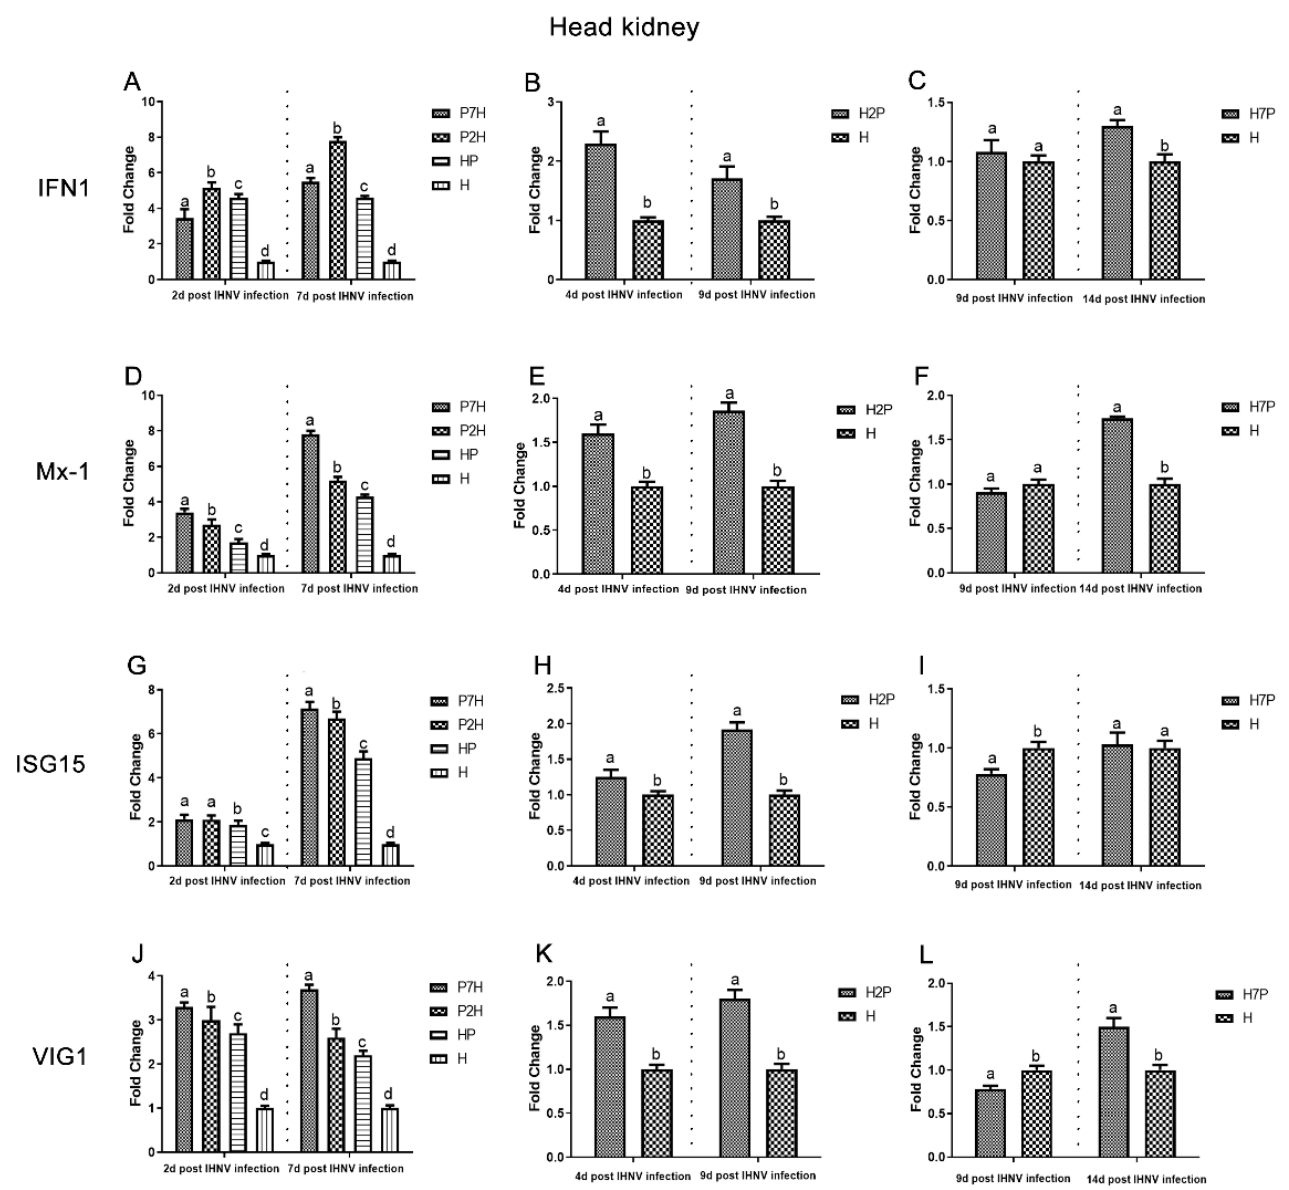
Figure 11. Gene expression of immune-related factors in the head kidney based on qRT-PCR evalua- tion. Data represent relative values with respect to IFN1 , Mx-1 , ISG15 , and VIG1 gene expression. Different letters indicate statistically significant differences ( p < 0.05). ( A – C ) IFN1 ; ( D – F ) Mx-1 ; ( G – I ) ISG15 ; ( J – L ) VIG1 .